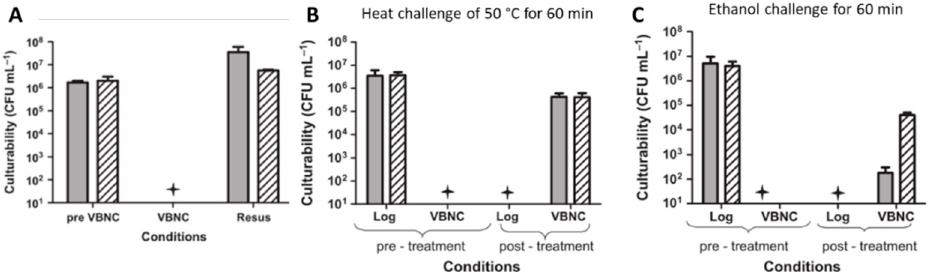
Figure 3. Antimicrobial effectivity screening of V. vulnificus (bars represent results of two different strains) in the viable but non-culturable (VBNC) state (adapted from [28]). ( A ) Resuscitation from the VBNC state. Shown is the culturability of the various cell populations examined. “Pre-VBNC” represents log-phase cells, “VBNC” represents culturability of these cells following induction into the VBNC state, and “resus” represents culturability of VBNC cells following resuscitation at 21 °C in artificial seawater. ( B , C ) Susceptibility of V. vulnificus exposed to different stresses. “Pre-treatment” represents control logarithmic and VBNC cells of V. vulnificus not exposed to any treatment. “Post-treatment” represents logarithmic and VBNC cells of V. vulnificus subjected to challenge. The star represents plate counts below the detection limit (<10 CFU/mL).